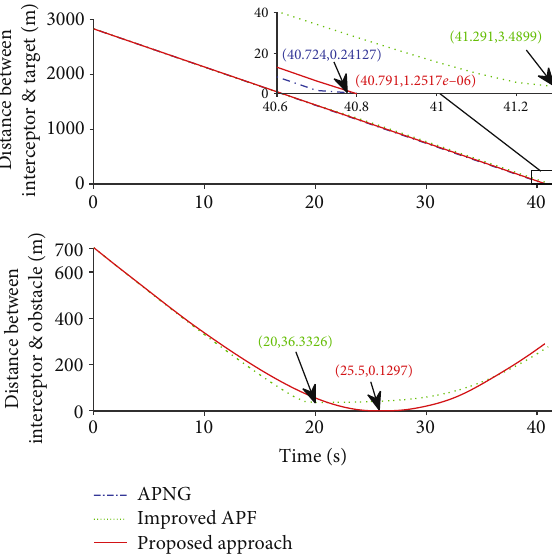
Figure 15: Changes of two distances in case